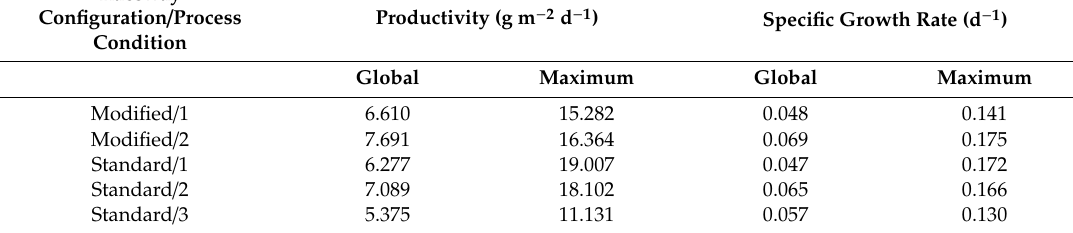
Table 3. Biomass productivities and specific growth rates obtained in the two raceways used. Productivity values are presented considering the dry weight. Values represent an average of two biological replicates.